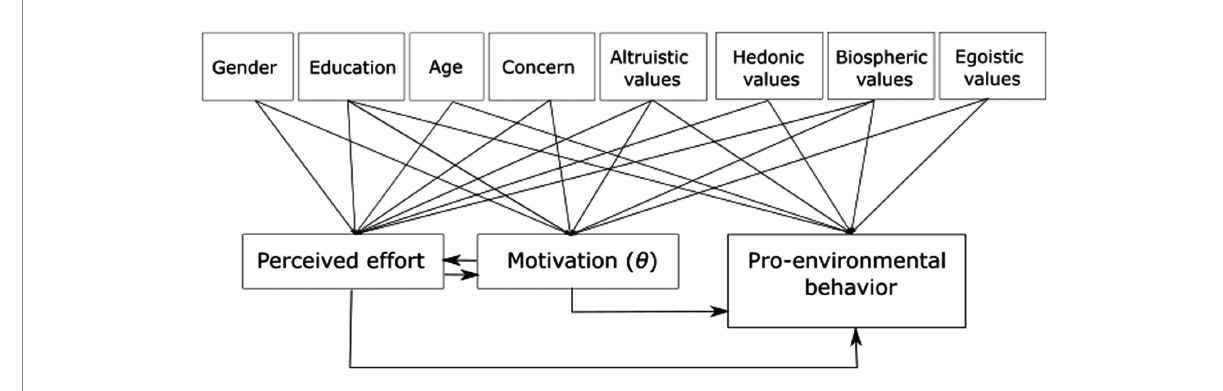
FIGURE 2 Overview of non-recursive model 4, with missing arrows from predictors ( x ) showing a relation that was restricted to 0.